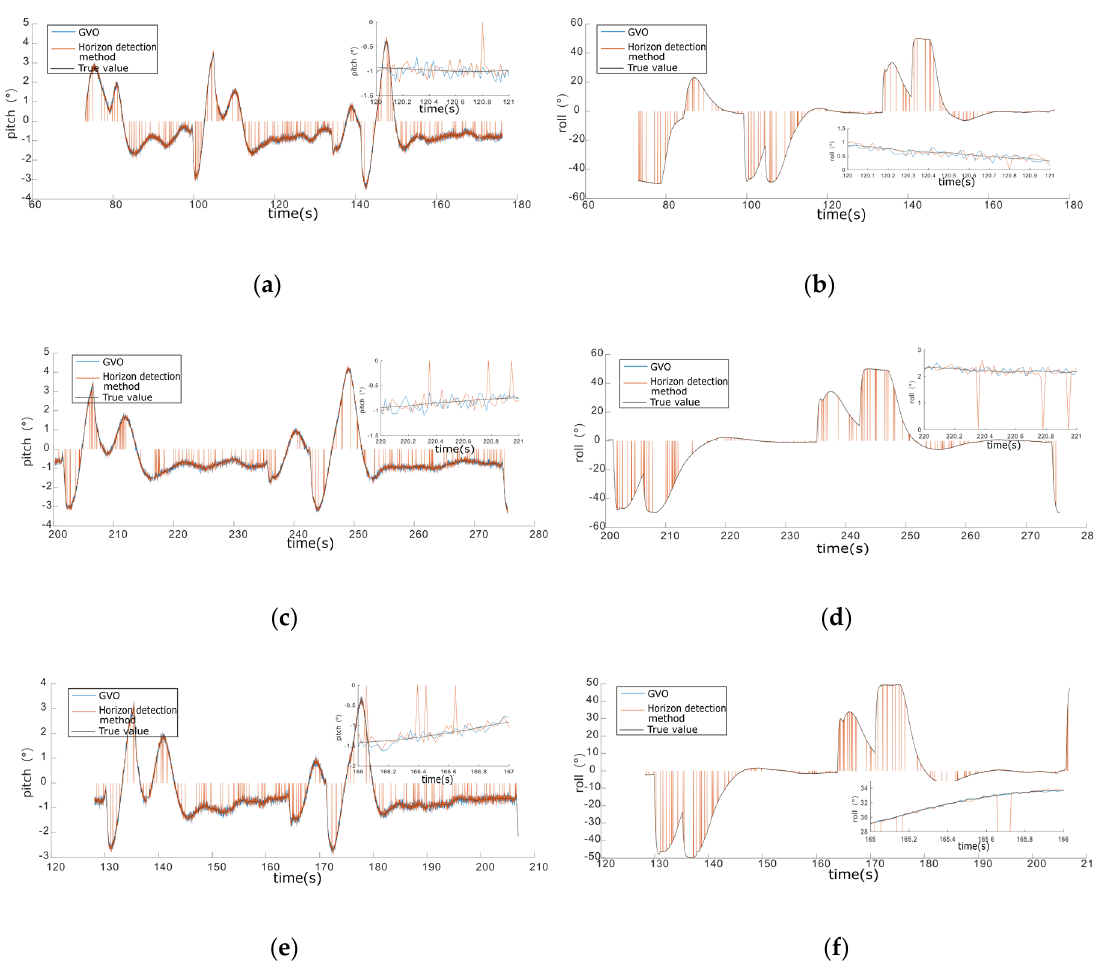
Figure 8. The simulation results of GVO and horizon detection method in the plain area. ( a ) Pitch angle of 100 m height. ( b ) The roll angle of 100 m height. ( c ) Pitch angle of 200 m height. ( d ) The roll angle of 200 m height. ( e ) Pitch angle of 300 m height. ( f ) The roll angle of 300 m height.